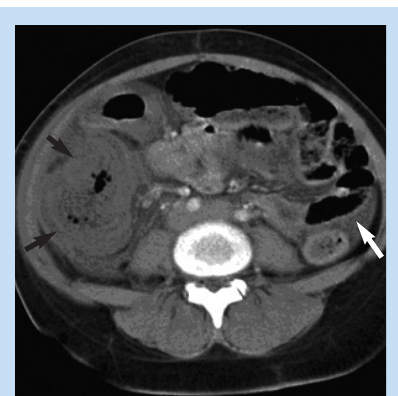
Fig. 5. Contrast-enhanced CT scan demon- strating the thick-walled right colon (black arrows) and mesenteric stranding. Note free fluid in the left paracolic gutter (white arrow).